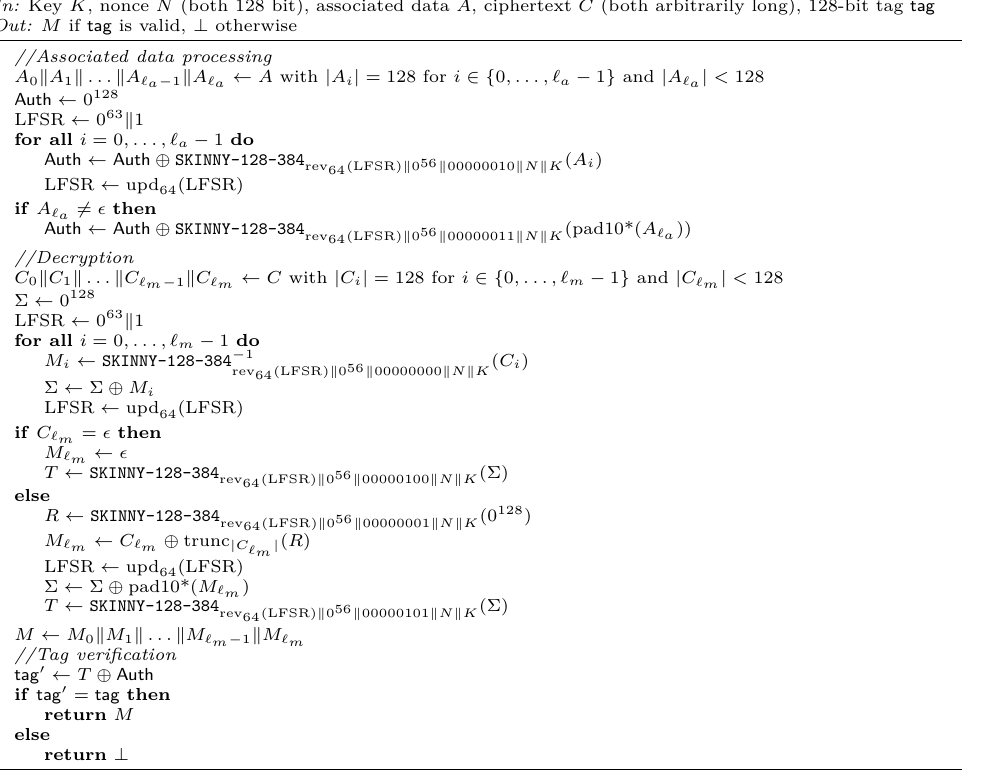
Algorithm 2 The decryption algorithm SKINNY - AEAD - M1 - Dec ( K,N,A,C, tag ) In: Key K , nonce N (both 128 bit), associated data A , ciphertext C (both arbitrarily long), 128-bit tag